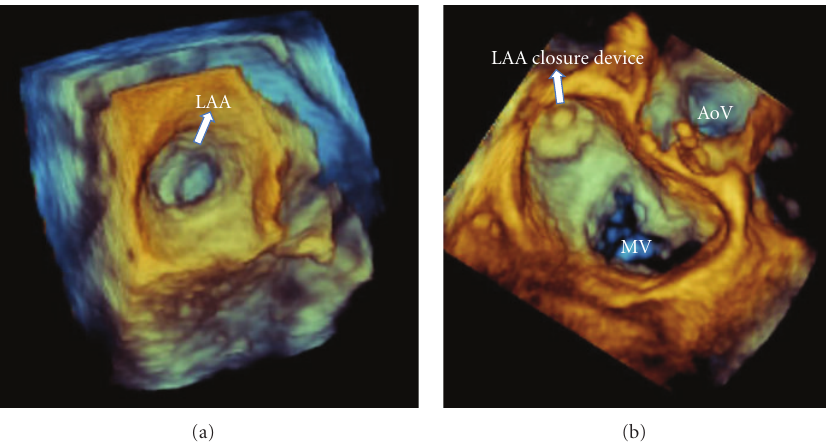
Figure 1: Real-time three-dimensional transoesophageal echocardiographic imaging of the left atrial appendage as seen from the left atrial perspective. (a) Preprocedural view of LAA. (b) LAA closure device deployed. (LAA: left atrial appendage; AoV; aortic valve; MV; mitral valve).